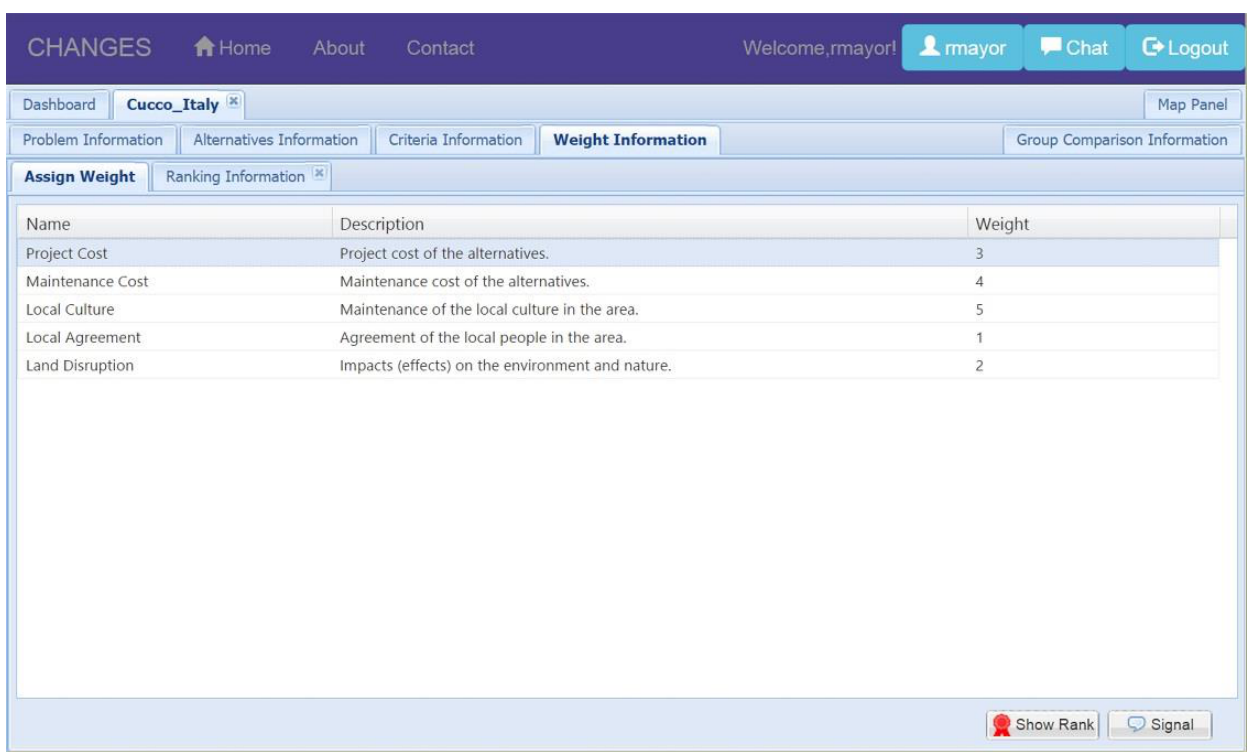
Figure 13. An example evaluation of Alternatives vs. Criteria.